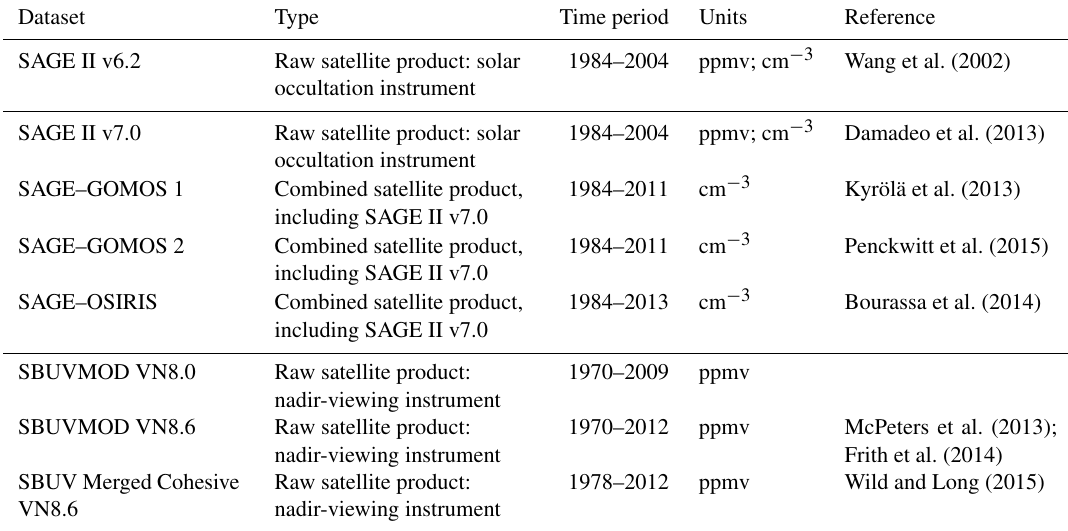
Table 1. Overview of the satellite ozone datasets used in this